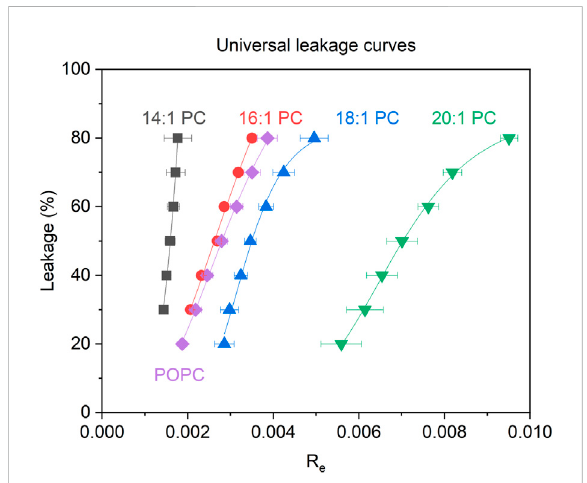
FIGURE 4 Calcein leakage L after 1 h as a function of the membrane- bound tolaasin to lipid mole ratio (R e ) for LUVs consisting of the tested lipids (see color code in the fi gure) triggered by tolaasin. Errors of R e are standard errors of the linear regression of the equi-activity lines (see Supplementary Material).